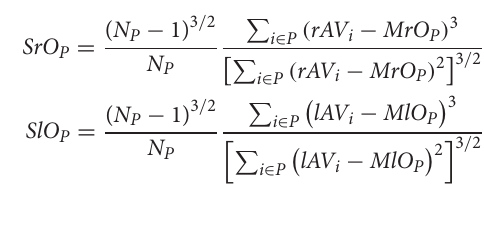
of the functional originalities in each plot P, noted as SrO P